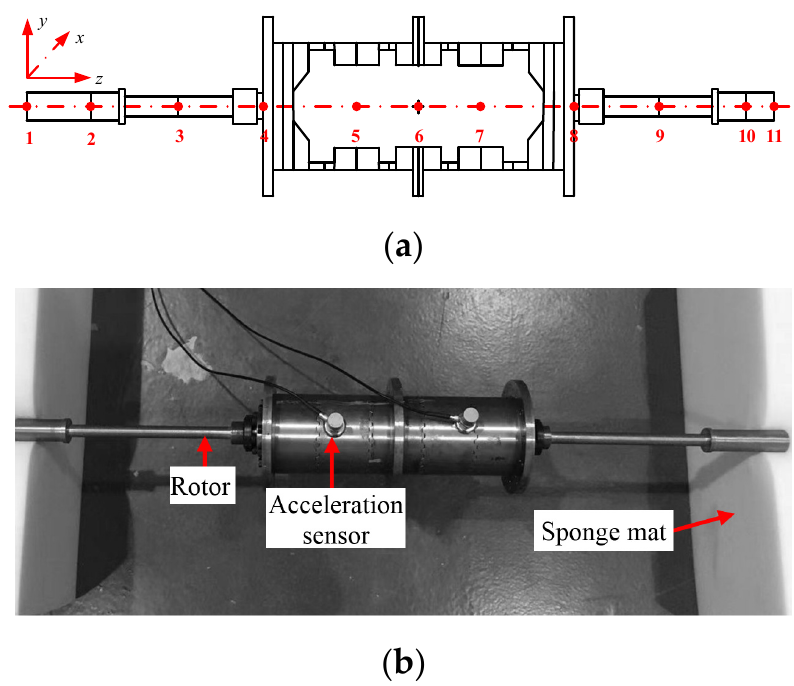
Blade position Figure 4. Assembly process for the total matrices after Guyan DOF reduction. 3. Modeling Method Validation through a Test Rotor In order to verify the modeling method proposed in this paper, a rotor with both